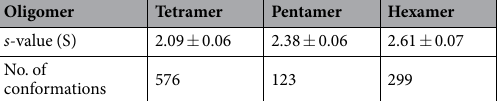
Table 2. Average sedimentation coefficients for A β 42 tetramers, pentamers and hexamers based